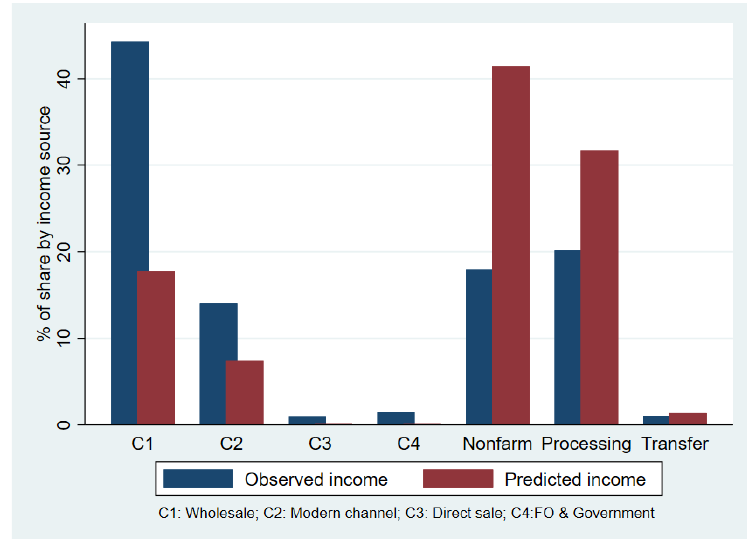
Figure 3. Detailed decomposition of each income source to inequality.